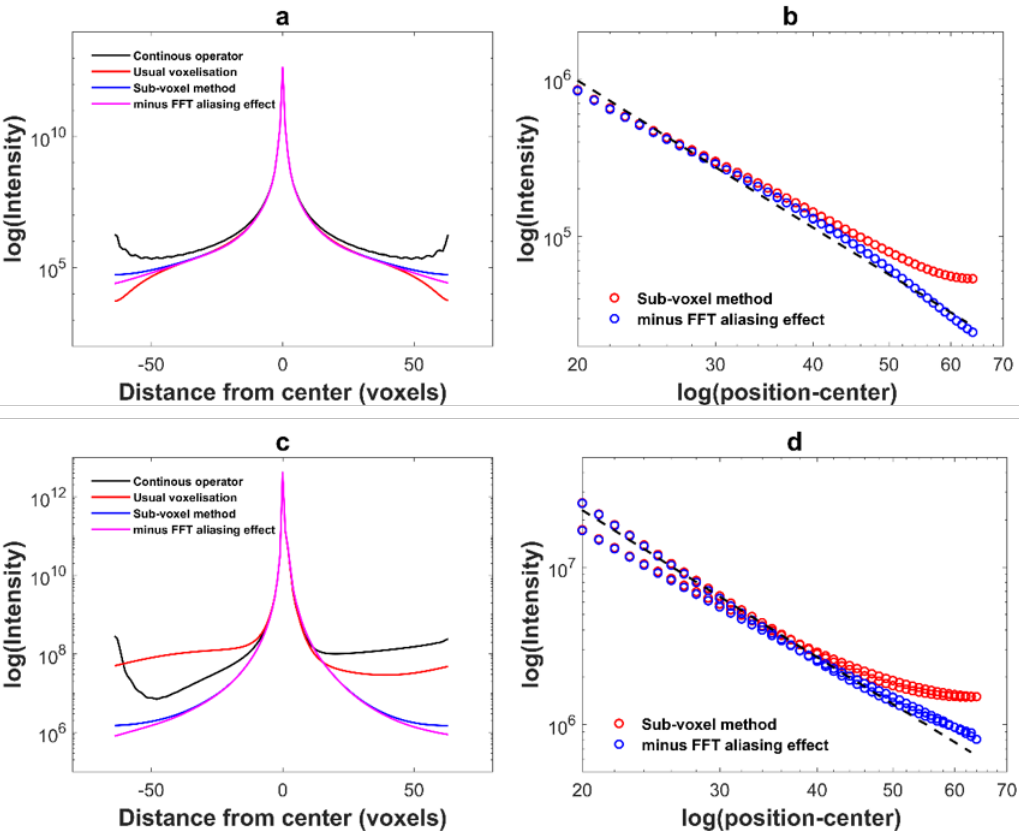
Figure 6. Simulated diffracted intensity as a function of the pixel position (logarithmic scale). 3D configuration is represented in a 1D plot by making the sum in each plane along an x -axis. Different way for computing the displacement fields are studied for a dislocation loop with a 𝑎 Burgers vector lying in a ( 111 ) slip plane. ( a ) Diffracted vector studied is G (200) corresponding to G · b = 0. ( b ) Log/log representation of the intensity vs. | i − i 0 | . ( c ) and ( d ) same as ( a ) et ( b ) but the diffracted vector is G (002) ( G ∙ b = 1).